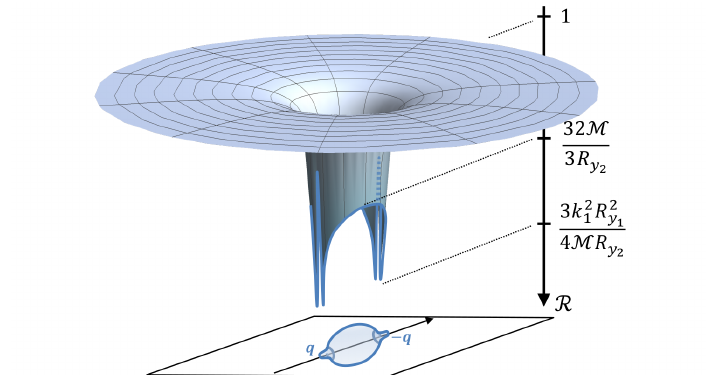
Figure 15 . Redshift factor of the neutral three-bubble solutions in the spherical coordinates ( r, θ ) of (4.27). The surface of the bubble is at r = ‘ + 2 σ